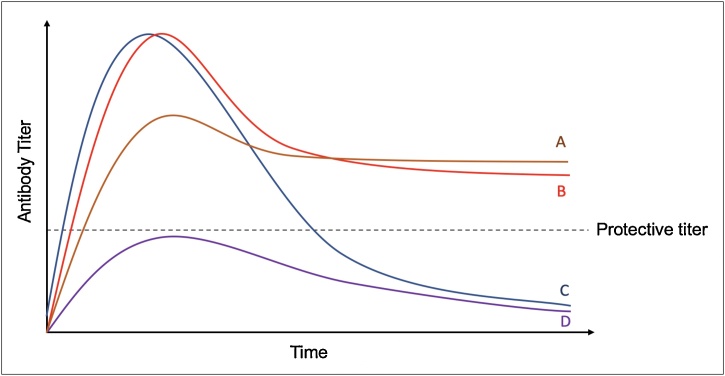
The durability of antibody responses over time in 4 different infection/vaccination scenarios.